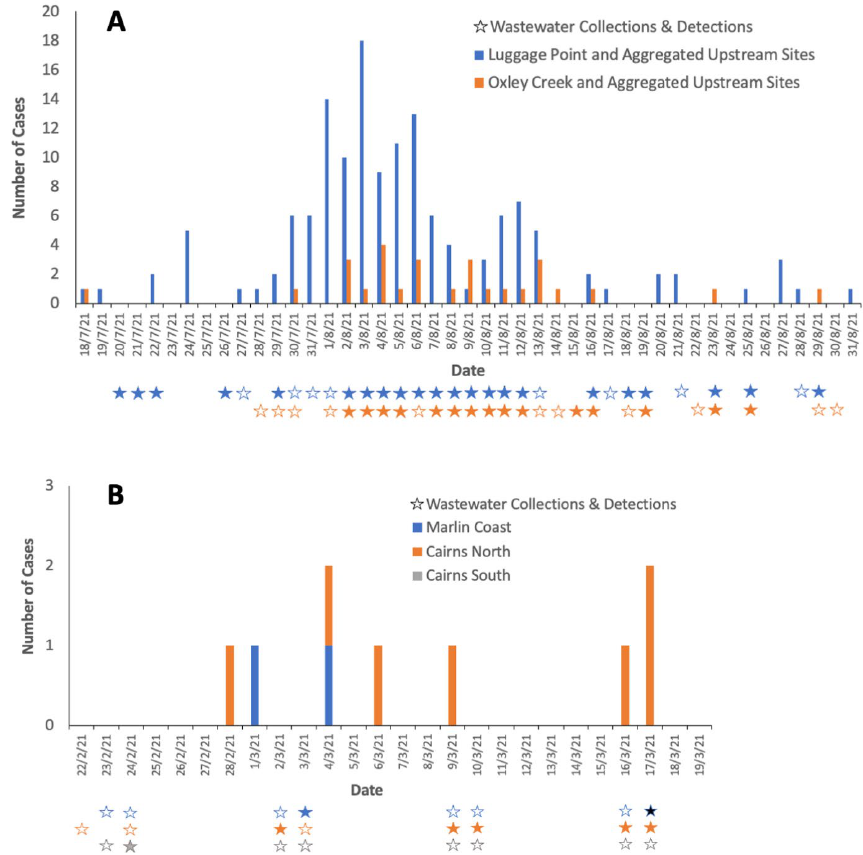
Figure 4. ( A ) Brisbane Inner West cluster. COVID-19 case notifications per statistical area 2 region and wastewater detections in related catchments from 15 July to 31 August 2021; ( B ) Cairns cluster. COVID-19 cases and wastewater detections from three wastewater treatment plant catchments in from 22 February to 19 March 2021. Cases per day are shown in bars. For each catchment, hollow stars indicate no wastewater detections, solid coloured stars indicate positive detections, and absence of a star indicate that no samples were